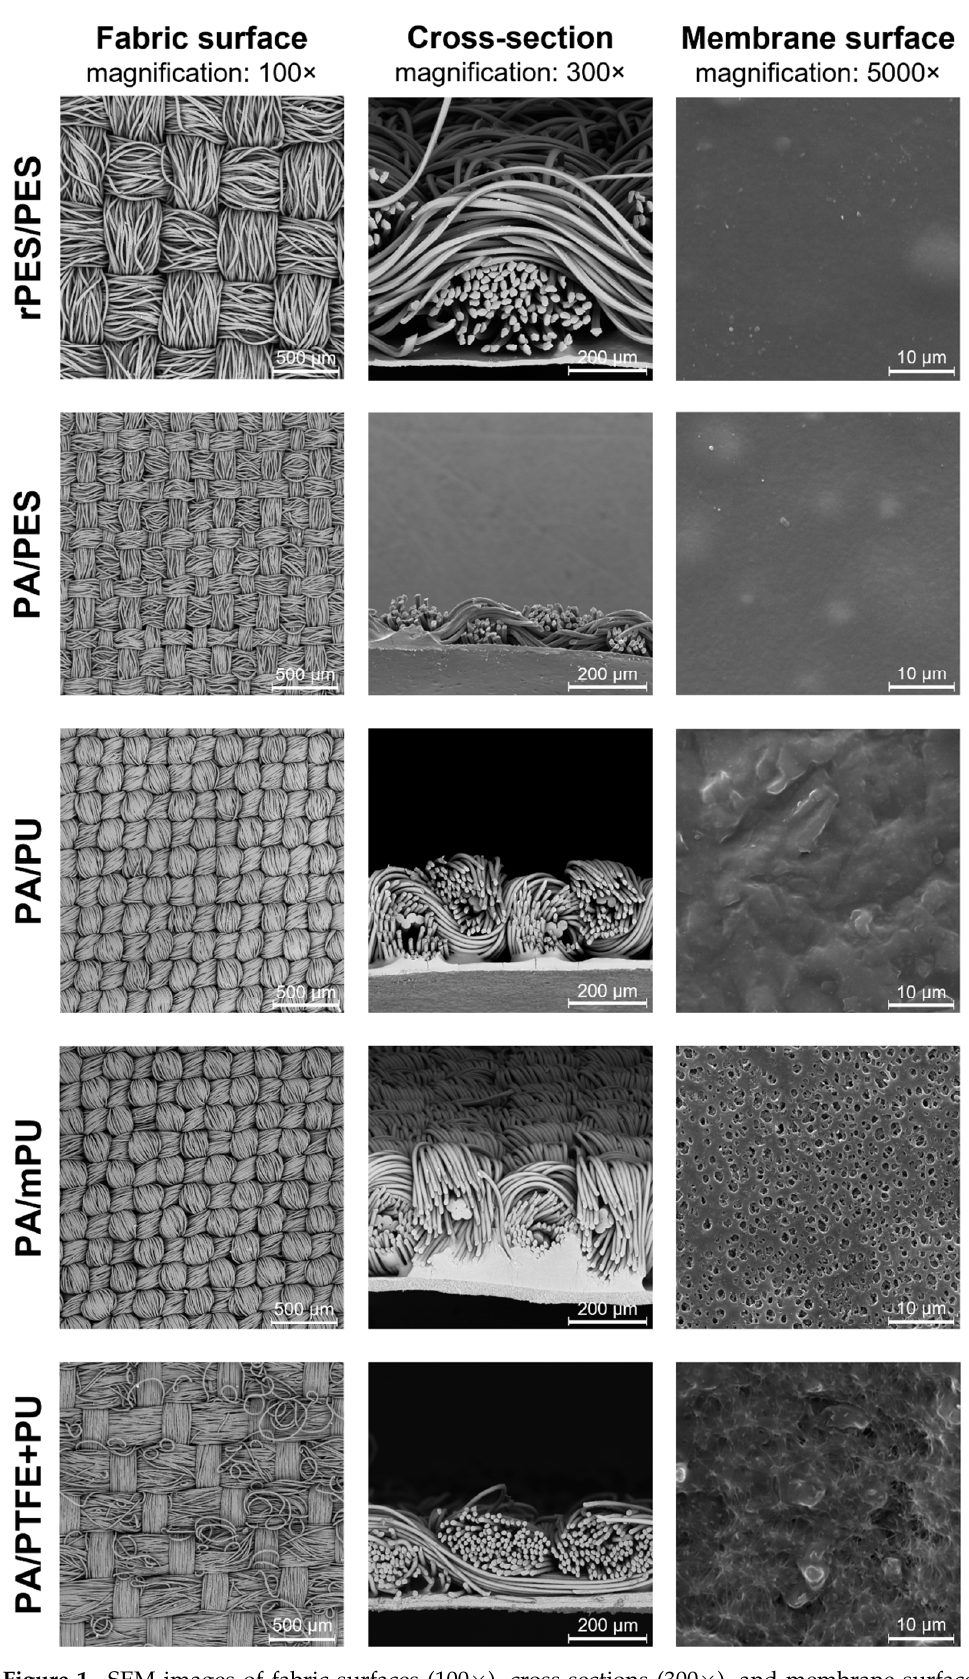
Figure 1. SEM images of fabric surfaces (100×), cross-sections (300×), and membrane surfaces (5000×) of studied materials.